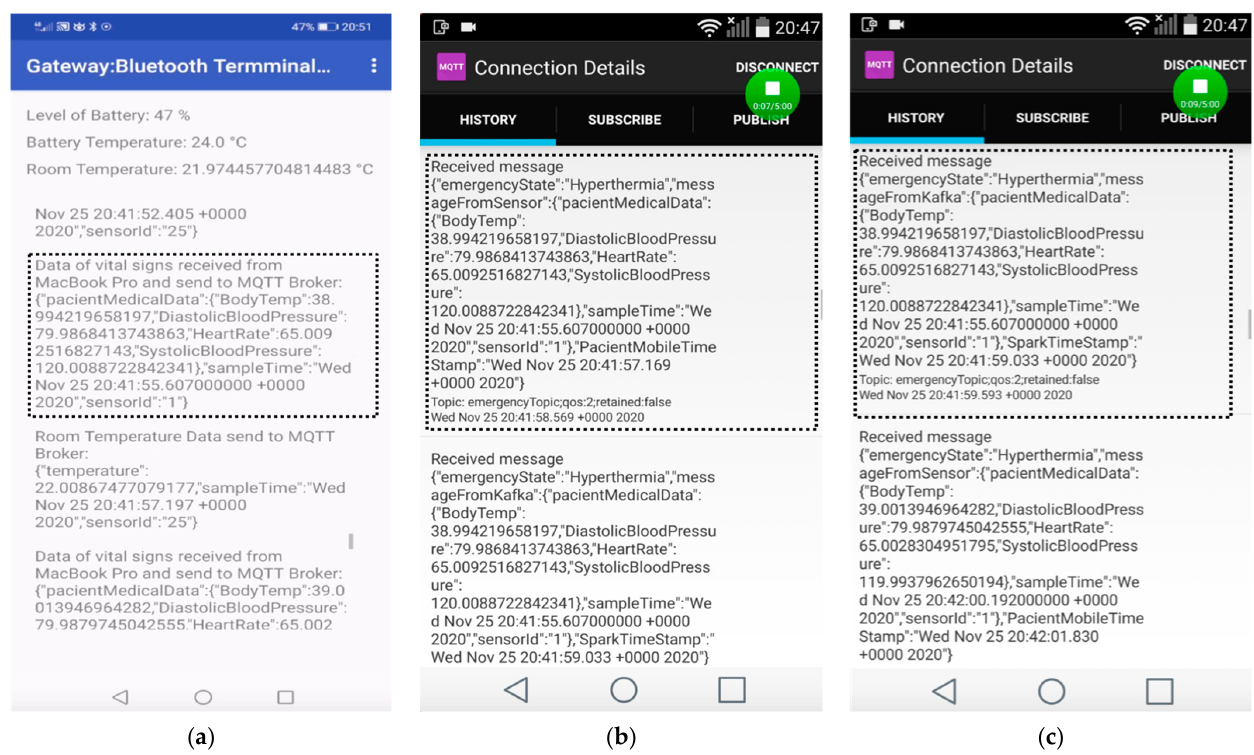
Figure 21. Smartphone log extracts show: ( a ) the vital sign data collected by the patient’s smartphone at home. ( b ) The emergency message generated by alert manager 1 and received by the paramedic’s smartphone ( c ) The emergency message generated by alert manager 2 and received by the paramedic’s smartphone.